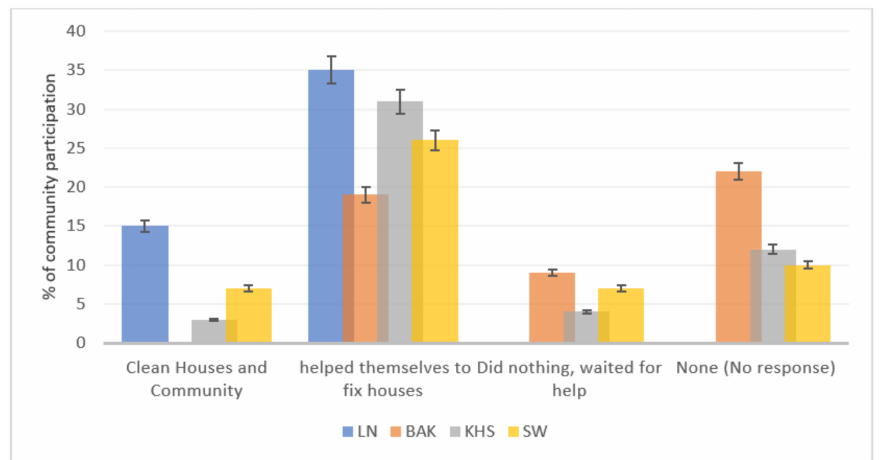
Figure 9. Community participation in flood-affected